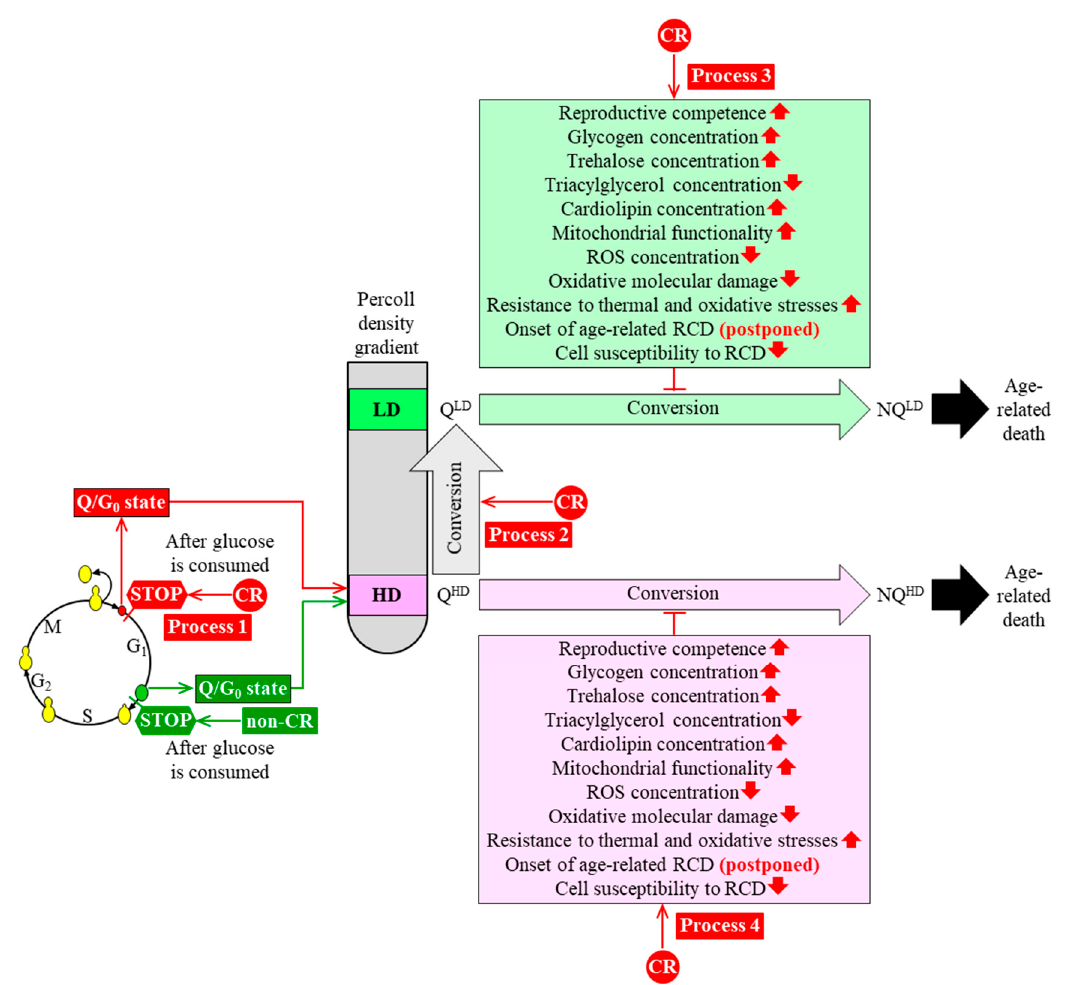
Figure 3. A hypothesis on how caloric restriction (CR) can slow chronological aging of budding yeast by altering the chronology and properties of quiescent (Q) cells. The hypothesis postulates that CR delays yeast chronological aging by targeting four processes within Q cells. See the text for more details. Other abbreviations: HD, high-density cells; LD, low-density cells; Q HD , quiescent cell of high density; QLD, quiescent cell of low density; NQHD, non-quiescent cell of high density; NQLD, non- quiescent cell of low density; RCD, regulated cell death; ROS, reactive oxygen species. Increased by CR; Decreased by CR; ˧ Slows the conversion of QLD cells into NQLD cells or the QHD-into- NQHD cell conversion.